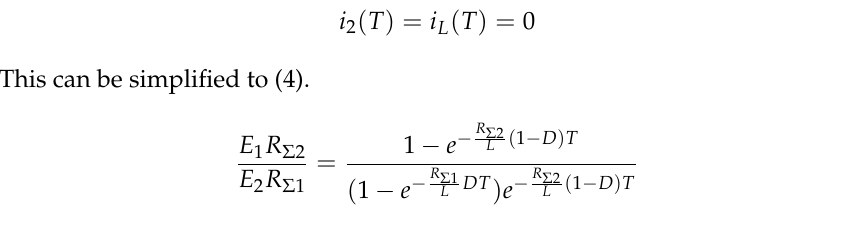
current at (cid:1872) = 5.1 × 10 (cid:2879)(cid:2873) , which is 1.7143 A. The relative error between them is 3.25%, but this is due to the simulation time step setting. In practice, the maximum inductive current should occur at (cid:1872) = (cid:1830)(cid:1846) and be less than the simulated maximum value. After that, the inductor current decreases and decreases to zero at the end of the cycle. The results show the simulation model can truly express the equalization process.